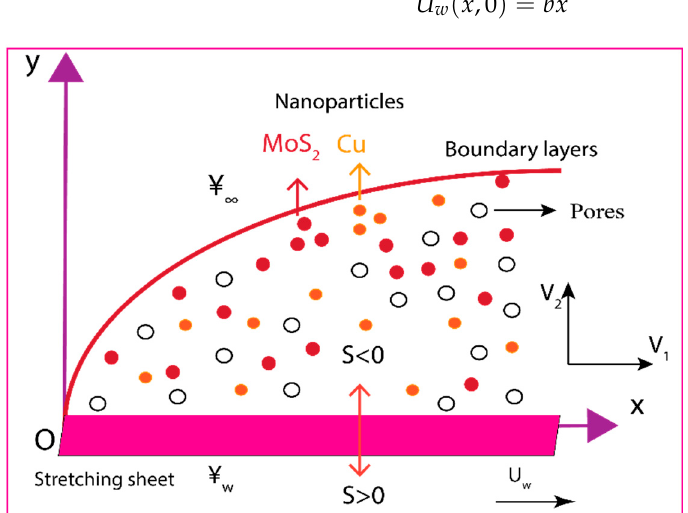
Figure 1. Schematic diagram of the flow model.